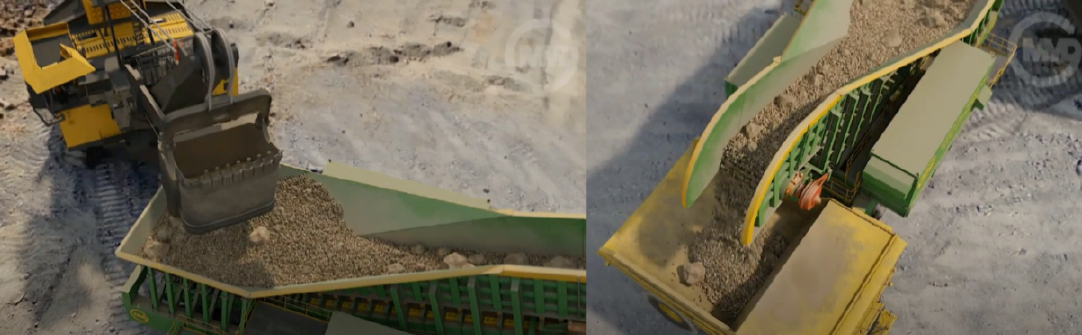
Figure 7. Material transfer sequence [23].